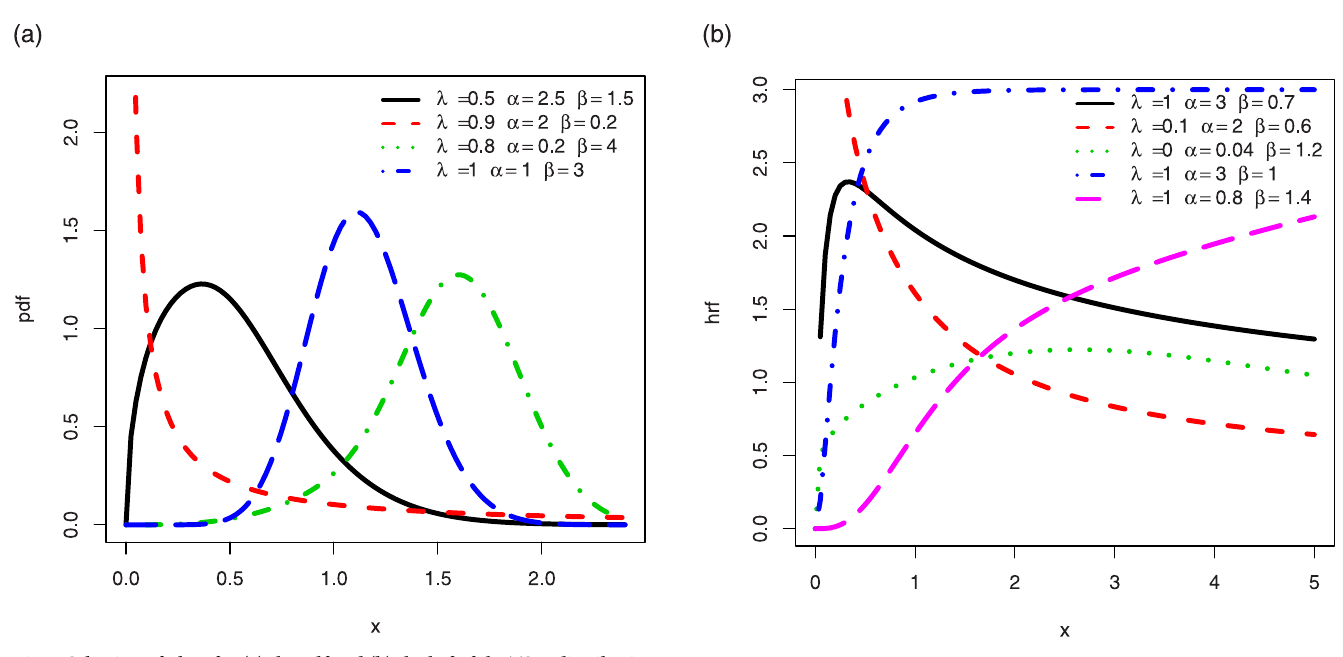
Fig 3. Selection of plots for (a) the pdf and (b) the hrf of the TSW distribution.